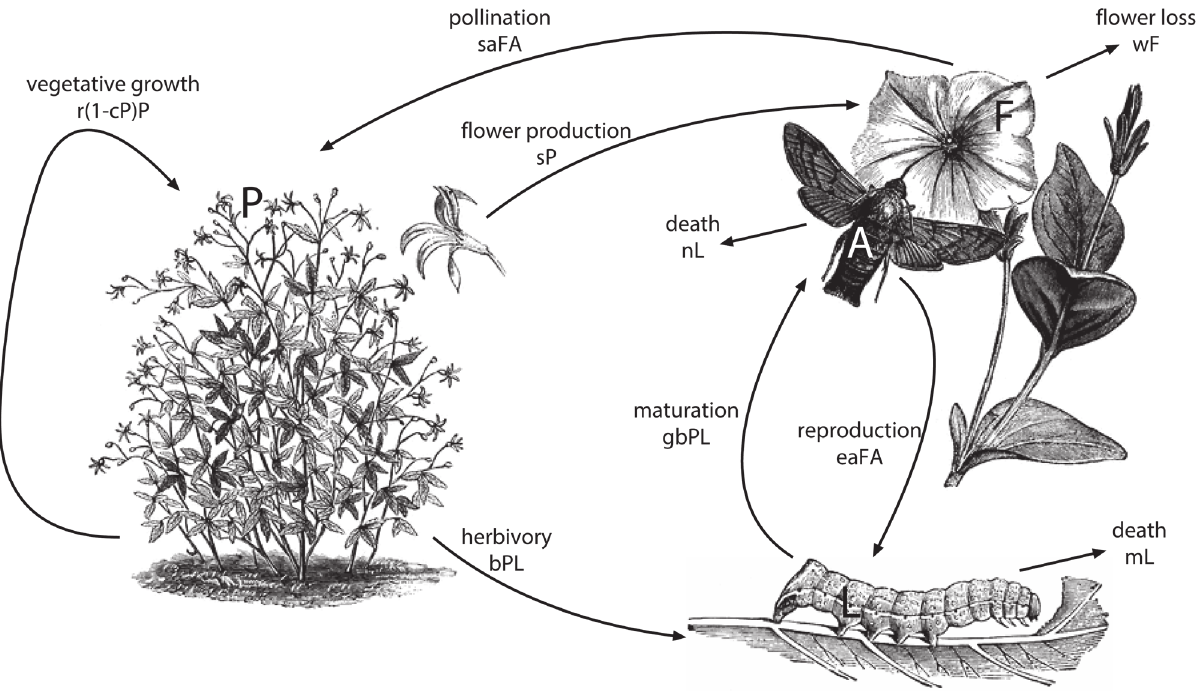
Fig 1. Interaction mechanism between plants ( P ), flowers ( F ), larva ( L ), adult insects ( A ) and associated biomass flows. Clipart sources: http://etc.usf.